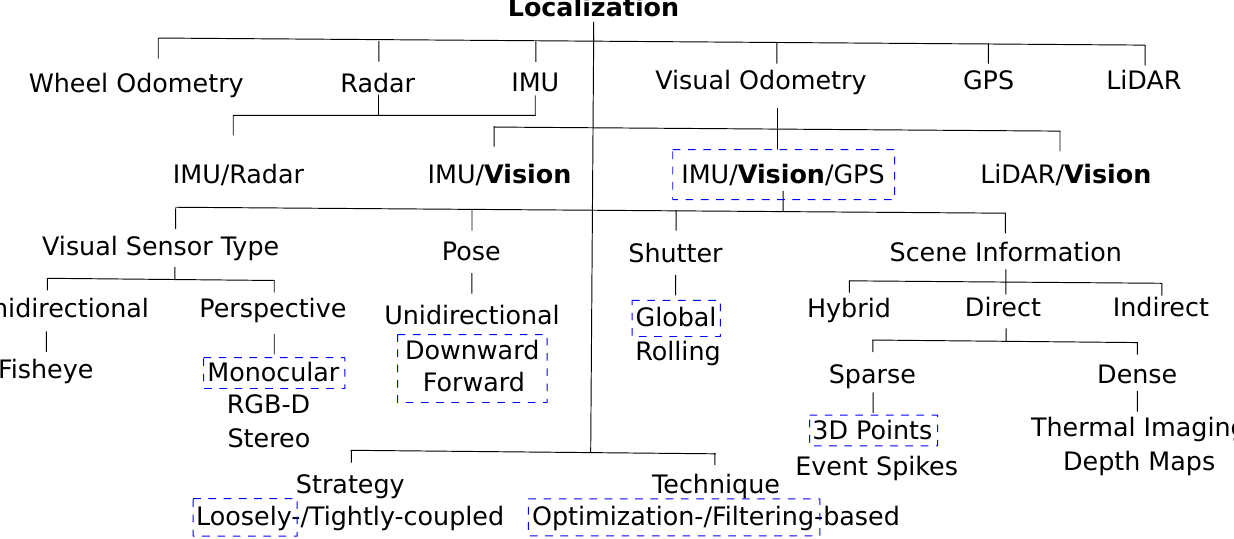
Figure 2. Visual odometry is generally categorized together with self-contained and global localiza- tion